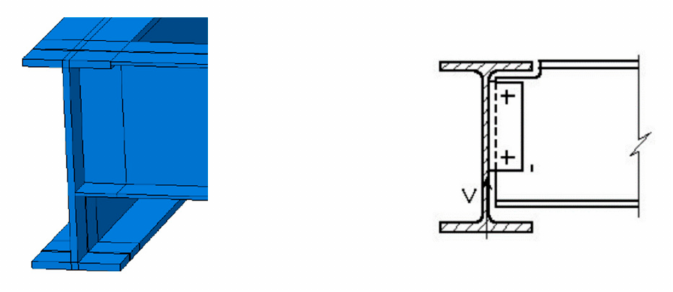
Figure 19. Left: Beam Connections in ABAQUS/CAE; Right: Beam Connections in